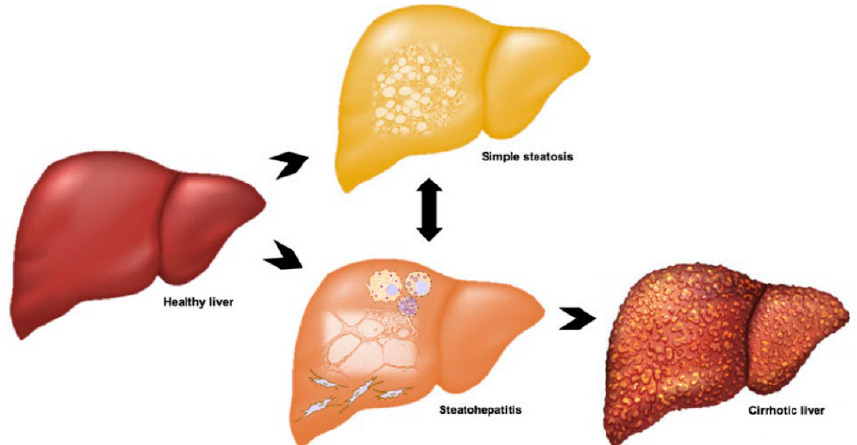
Figure 1. Clinical spectrum and progression of non-alcoholic fatty liver disease (NAFLD). Patients may present with simple steatosis due to lipid accumulation in hepatocytes, or non-alcoholic steatohepatitis (NASH), which is characterised by inflammation, hepatocyte death and fibrosis. Fibrosis can progress to cirrhosis and these patients have an increased risk of hepatocellular carcinoma.